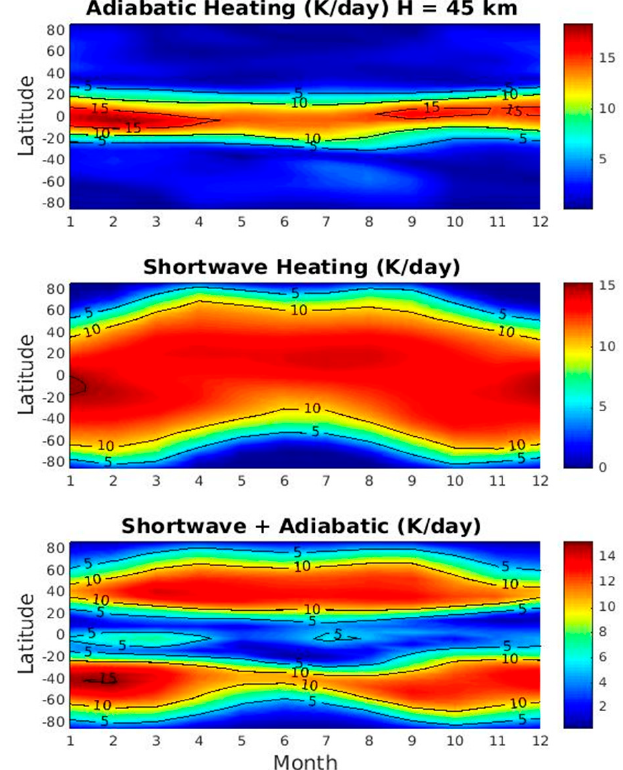
Figure 3. Seasonal variations of the adiabatic heating, short-wave heating, and the sum of adiabatic and short-wave heating (K/day) on the right-hand-side ( RHS ) of thermodynamic budget Equation (1) for DW1 at 45 km.